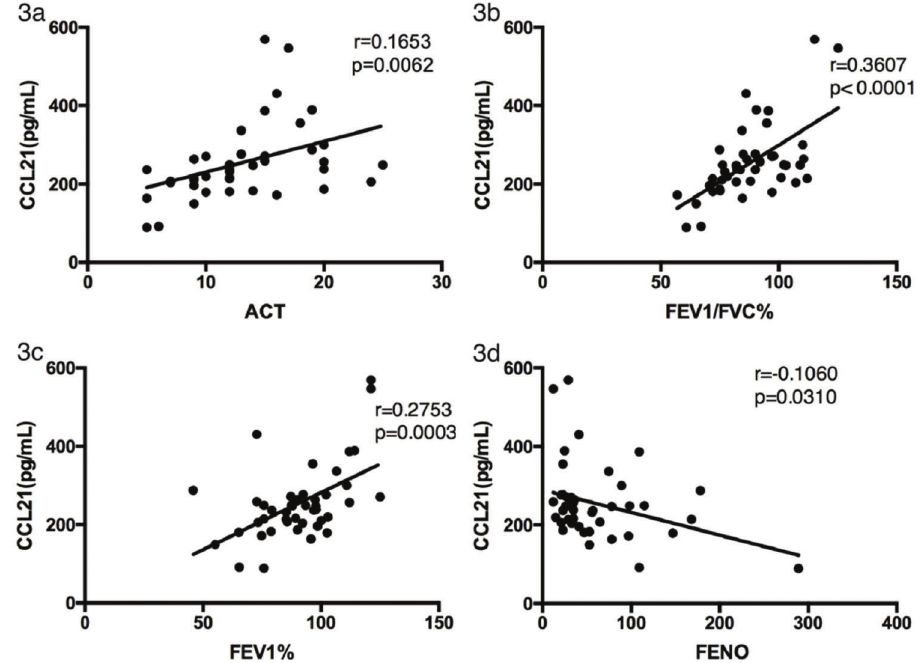
Figure 3 - Correlation between CCL21 levels and clinical characteristics in patients with asthma. The correlation analysis was performed to analyze the relationship between CCL21 levels and (a) ACT score, (b) FEV1, (c) FEV1/FVC%, and (d) FENO. ACT, Asthma Control Test; FEV1, forced expiratory volume in 1 second; FVC, forced vital capacity; FENO, fractional exhaled nitric oxide; CCL, chemokine